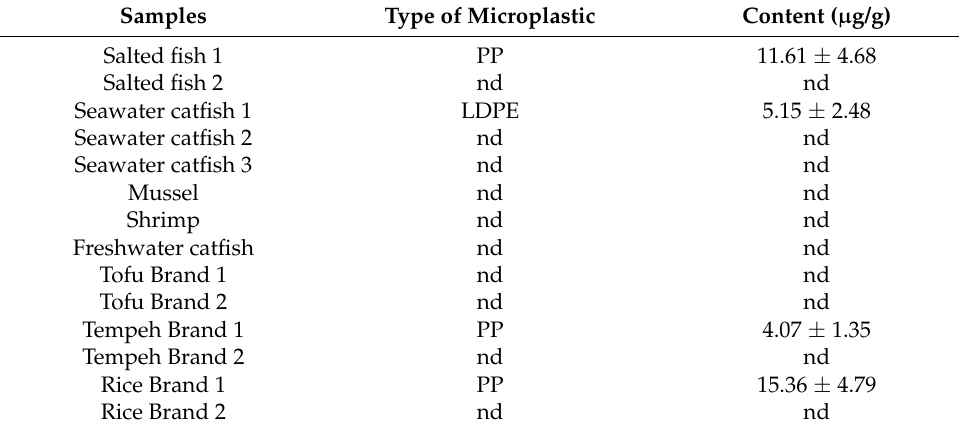
Table 2. Microplastic content in seafood and staple